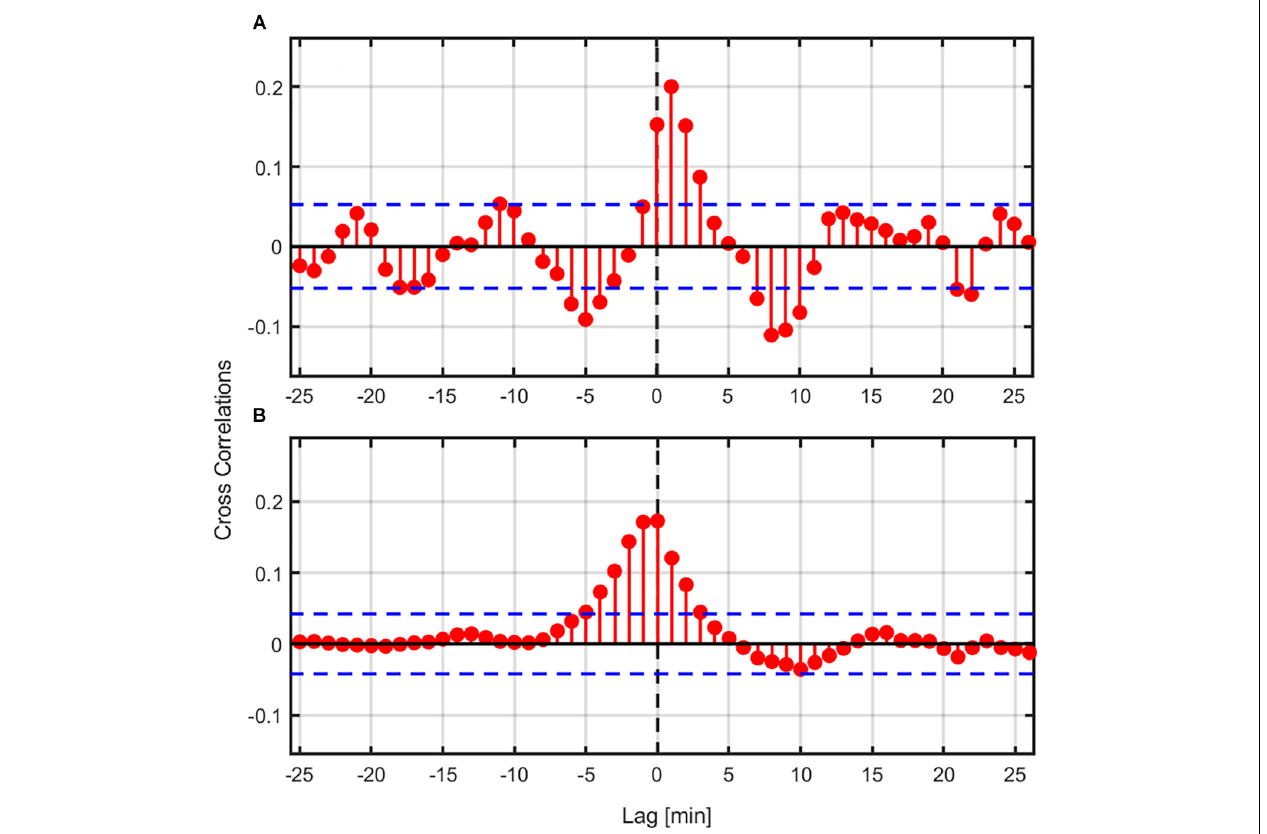
FIGURE 10 | Cross-correlations between 1-min fluctuations in the source terms [( Rn - G ) (cid:48) ] and turbulent heat flux (H (cid:48) ) (A) during sunlit periods ( Rn > 5 W m − 2 ), and (B) during dark periods ( Rn < 5 W m − 2 ). Dark periods include the time near totality, as well as nighttime periods. Blue lines indicate the approximate 95% confidence